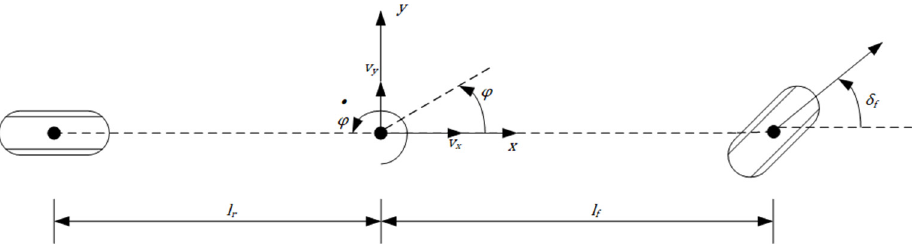
Figure 1. Vehicle dynamics model.